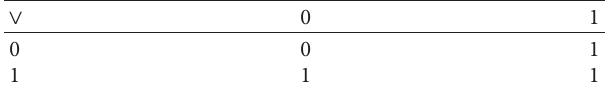
Table 2: The 0-1 diagonal